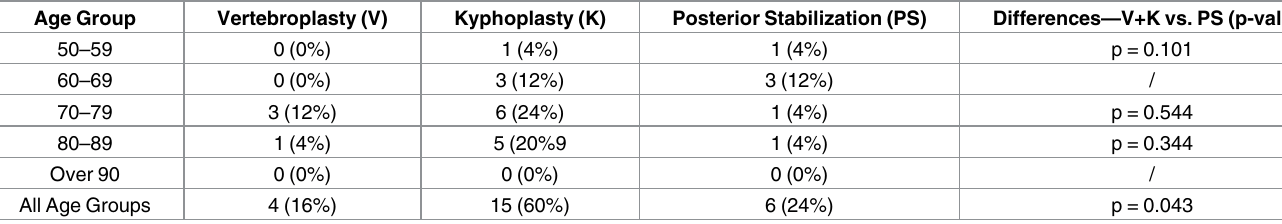
Table 2. Surgical procedure. Type of surgicalprocedure.